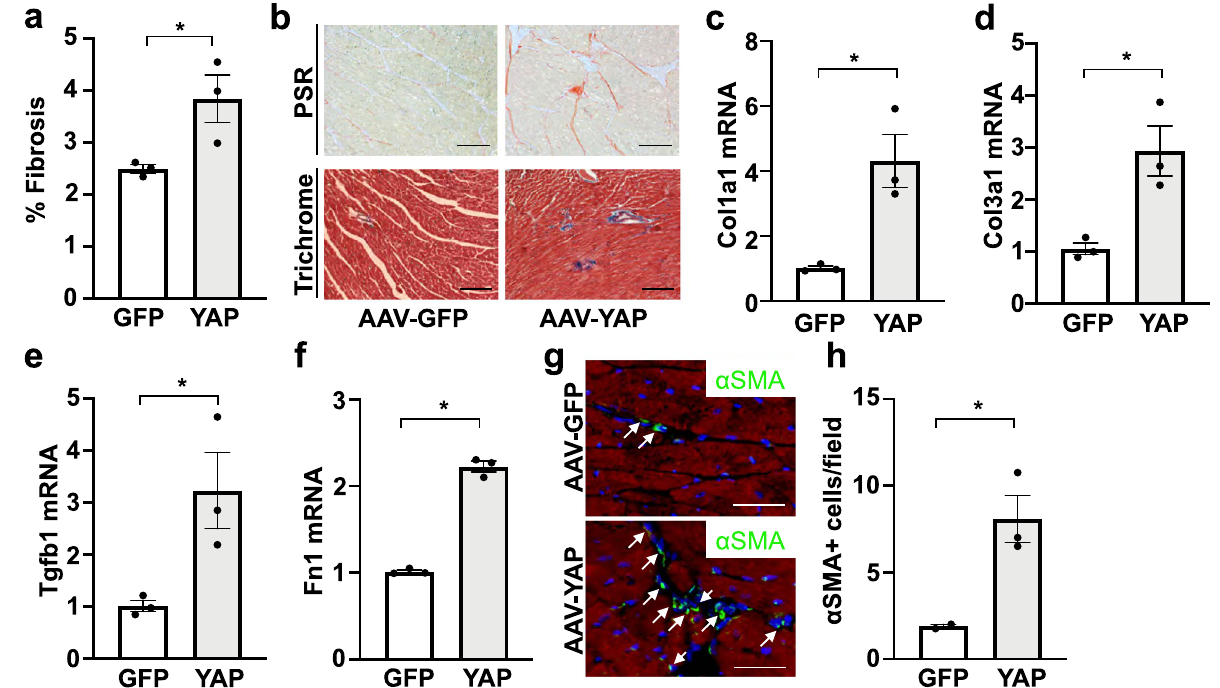
Figure 3. Indicators of fibrosis are upregulated in AAV-hTCF21-FLAG-YAP transduced hearts. Wild-type C57BL/6J mice were administered AAV-hTCF21-GFP or AAV-hTCF21-FLAG-YAP. ( a , b ) Hearts were stained with picrosirius red or Masson’s Trichrome to visualize collagen deposition. ( a ) The percent of picrosirius red (PSR)-positive staining was determined. ( b ) Representative images are shown. Scale bar, 200 μm. ( c–f ) RNA was isolated from LV tissue for qPCR analysis. ( g , h ) Hearts were sectioned for immunostaining to detect αSMA (green), cardiac troponin I (red), and nuclei (DAPI). White arrows identify αSMA-positive cells. Quantification of αSMA-positive cells in panel ( h ). Scale bar, 100 μm. N = 3 mice/group. *p < 0.05.